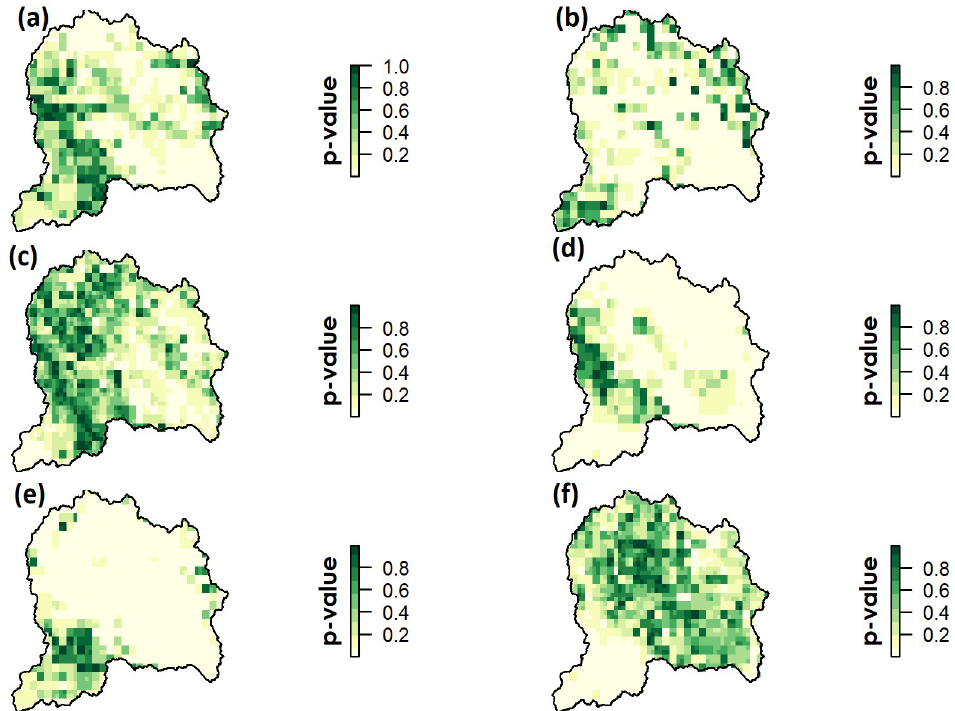
Fig 8. Annual correlation coefficient represented by p-values of NDVI with Tmax (a), Tmin (b) and precipitation (c). Similarly, seasonal correlation coefficient of NDVI with Tmax (d) Tmin (e) and Precipitation (f) in spring (Q2) over the UJRB during